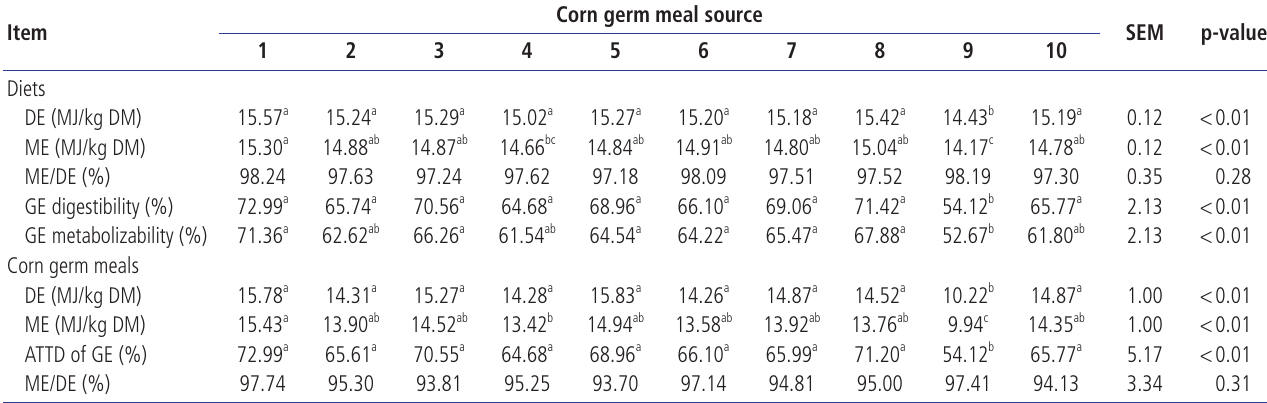
Table 5. Digestible energy (DE), metabolizable energy (ME), digestibility and metabolizability of gross energy (GE) and the ratio of ME to DE (ME/DE) of the 10 experimental diets, and DE, ME, apparent total tract digestibility (ATTD) of GE and the ratio of ME to DE (ME/DE) of the 10 corn germ meal samples fed to growing pigs 1) Corn germ meal source Item